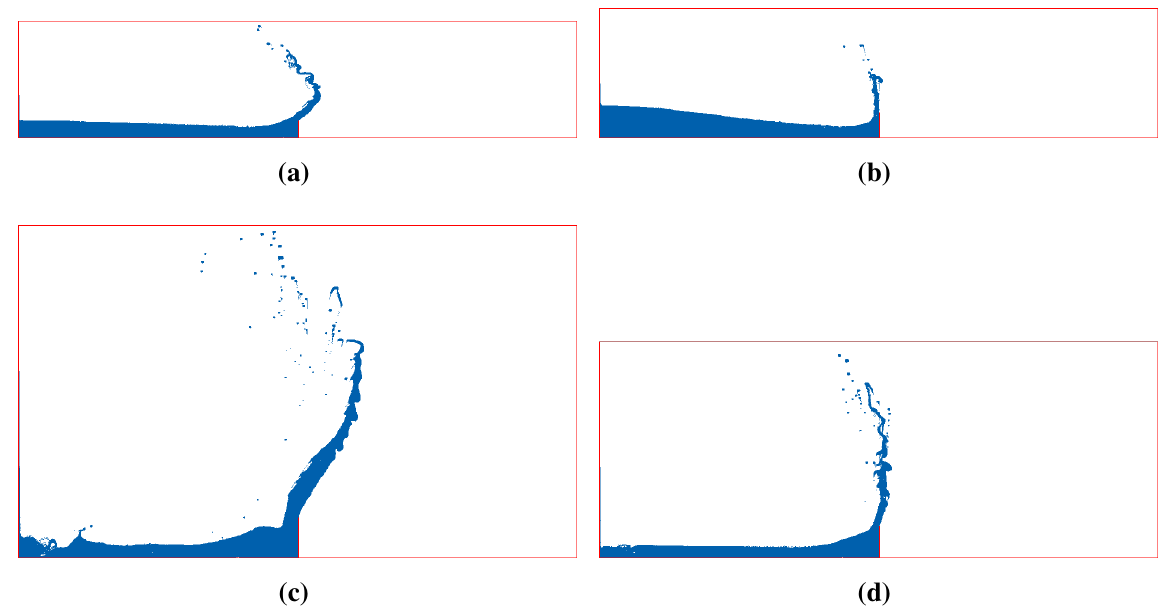
Figure 18. Results for the overtopping test case of Atherton [48] for four different cases. ( a ) Case 1, t = 0 . 5 s; ( b ) Case 4, t = 0 . 35 s; ( c ) Case 9, t = 0 . 6 s; ( d ) Case 11, t = 0 . 6 s.